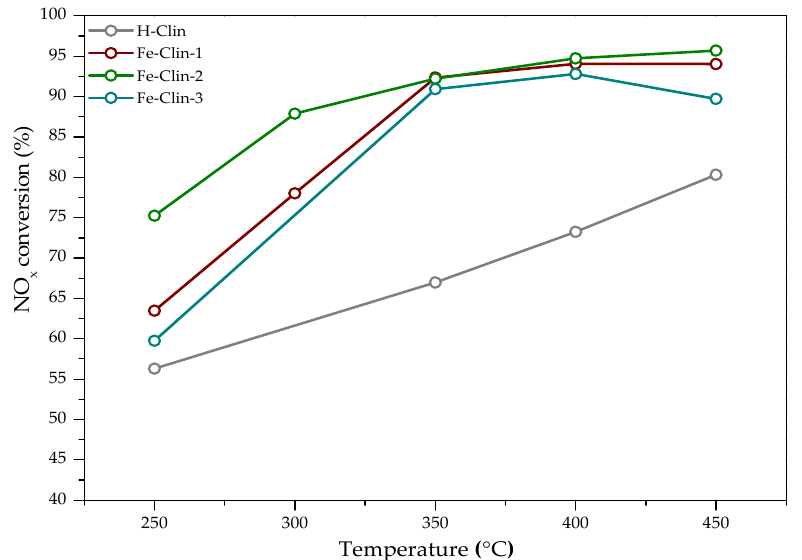
Figure 8. NO x conversion as a function of temperature for protonated clinoptilolite (H-Clin) and Fe-clinoptilolite catalysts (Fe-Clin-1, Fe-Clin-2, Fe-Clin-3) at GHSV = 9000 h − 1 . Table 3. N 2 selectivity of Fe-clinoptilolite catalysts.